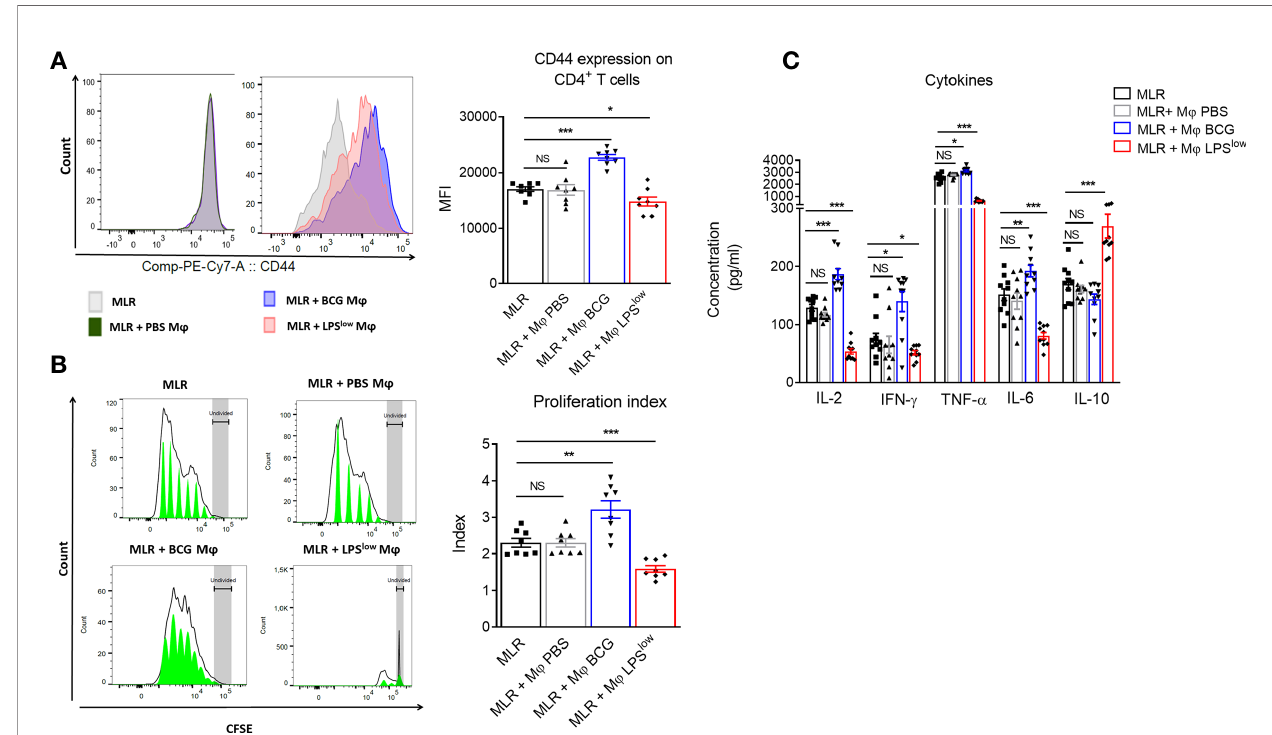
FIGURE 1 | Effects of trained-macrophages adding on CD4 + T cell proliferation, activation, and cytokine secretion in a mixed lymphocyte reaction. (A) Flow cytometry analysis of CD4 + T-cell activation after in vivo training during mixed lymphocyte reaction. Responder cells were constituted by puri fi ed CD4 + T cells derived from B10.D2 mice. Irradiated splenic cells from Balb/c mice constituted the stimulator cells. Cells were cultured in different conditions. Control groups were: CD4 + T cells alone in medium, irradiated Balb/c splenic cells alone in medium, CD4 + T cells with anti-CD3/CD28 antibody. Tested groups were: CD4 + T cells with irradiated Balb/c (MLR), MLR with PBS-trained Balb/c M j (bone marrow derived macrophages), MLR with LPS low -trained M j , MLR with BCG-trained M j . Each condition of co-culture was performed in a 10-plicate, and plates were incubated for 4 days at 37°C in 5% CO 2 . Overlaid histograms indicate a representative CD44 expression on gated CD4 + T cells of each condition. The column graph represents the mean fl uorescence intensity of CD44 expression ± SEM obtained from the 10-plicate of three independent experiments. (B) Flow cytometry assessment of CFSE-stained B10.D2 CD4 + T-cell proliferation cultured for 96 h in different conditions. CFSE graphs are representative of each co-culture condition. The fi rst peak represents the undivided cells. The black line represents the different cell populations that underwent division, and the green area shows the peaks of different generations of proliferating cells. The column graph represents the mean of the proliferative index of each condition ± SEM obtained from the 10-plicate of three independent experiments. (C) Levels of IL-2, IFN- g , TNF- a , IL-6, and IL-10 cytokines in the supernatant of the different MLR-trained M j conditions. Concentrations were assessed by ELISA and bar graphs represent the mean (pg/ml) ± SEM of 10-plicate of three independent experiments. The ANOVA test with Bonferroni correction was used to detect signi fi cant differences between the groups. Statistics are shown between the MLR group and the MLR + trained macrophages conditions. NS, non-signi fi cant; *p ≤ 0.05; **p ≤ 0.01; ***p ≤